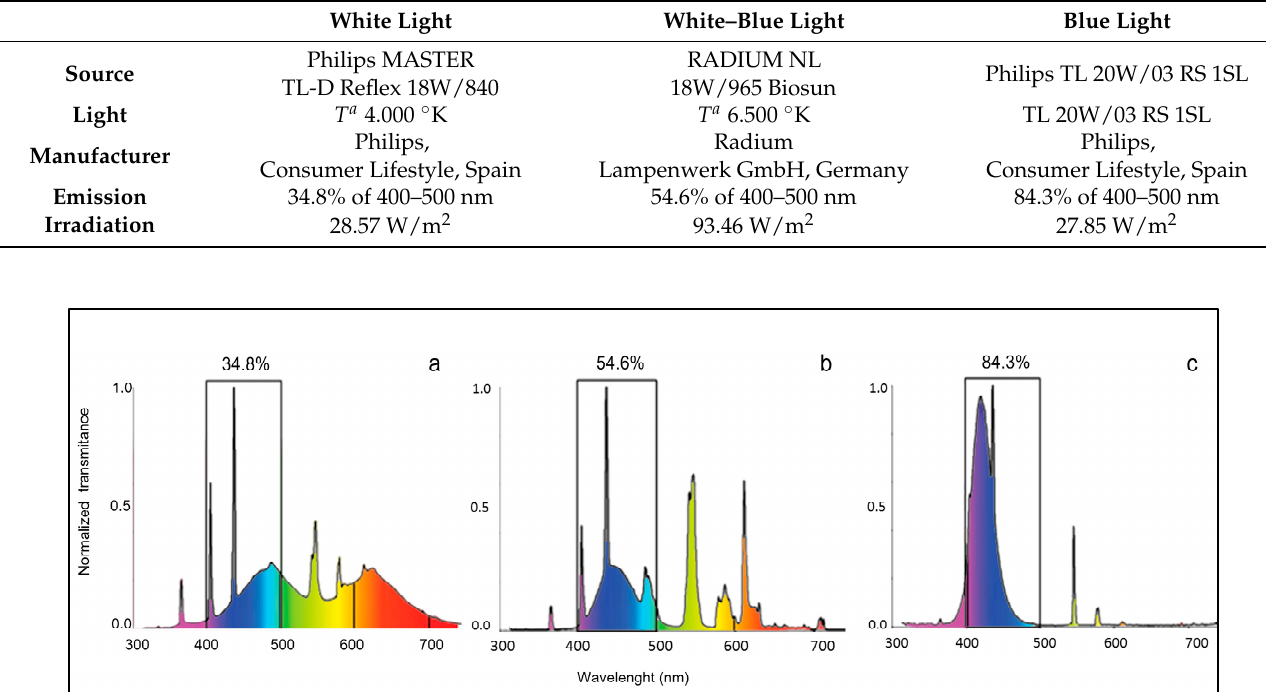
Table 3. Illumination source details. Irradiancies were measured using a photoradiometric TektronixJ1800 (TekLumaColor, Wilsonville, OR, USA). The spectral composition of the light source was determined